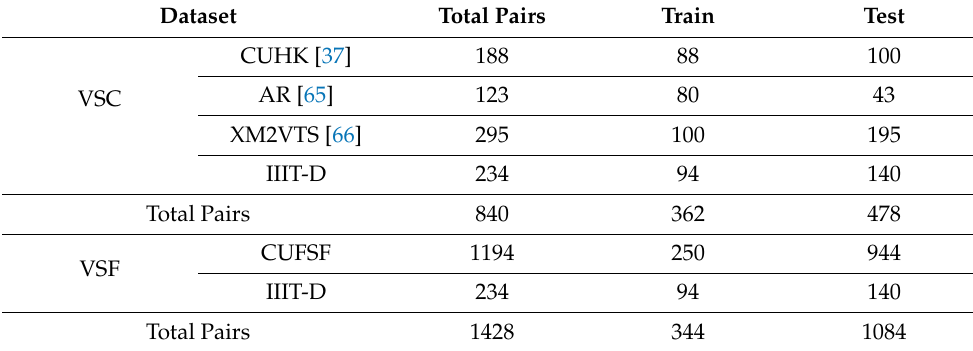
Table 8. Details of augmented